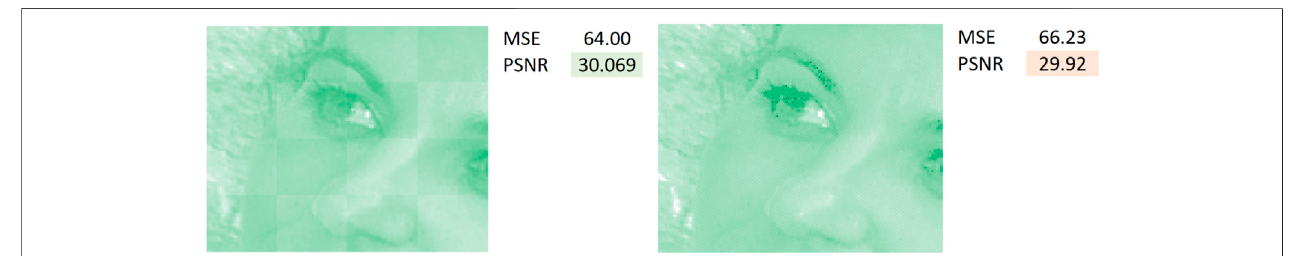
FIGURE 7 | Illustrative example